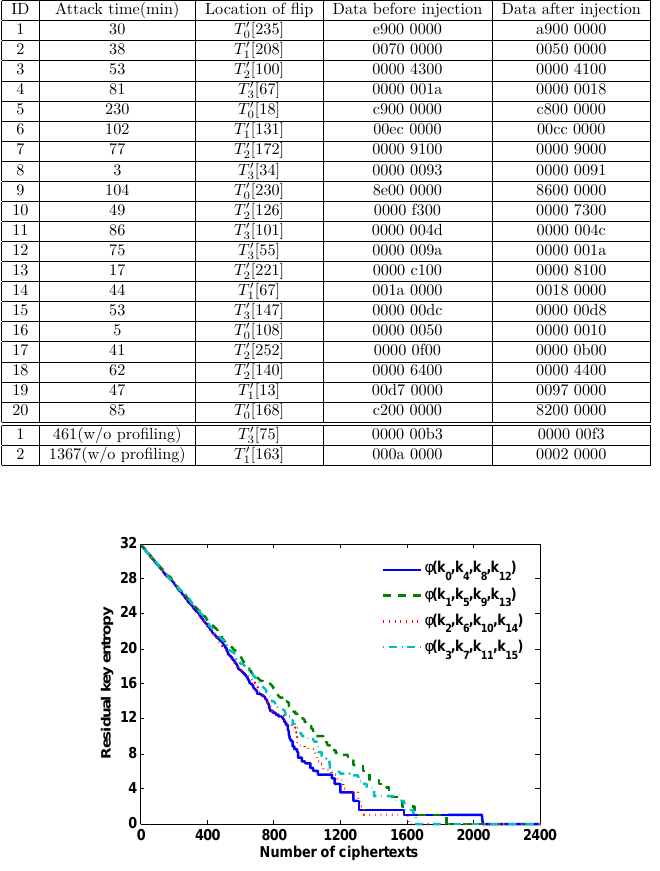
with or w/o profiling. i